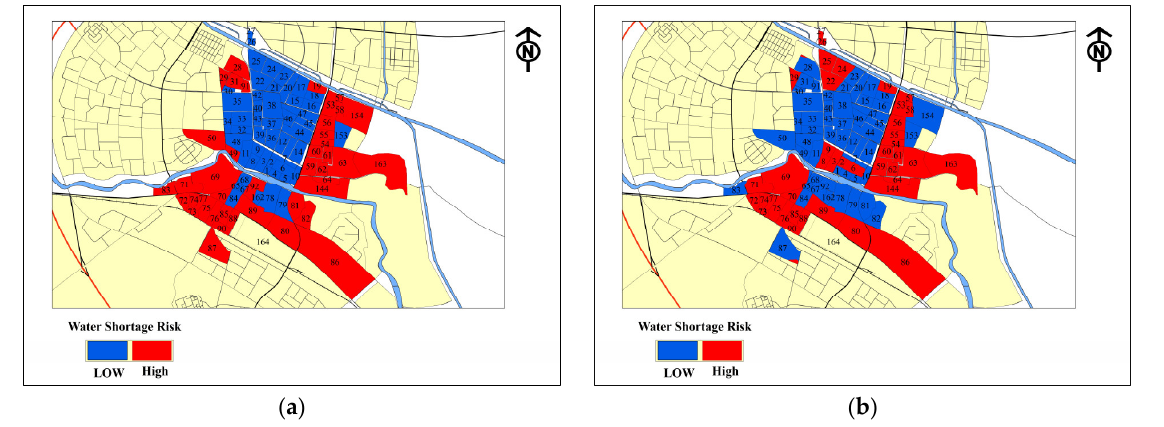
Figure 6. Map ( a ) was created by the direct representative method in GIS, using the prediction results of NB, whereas map ( b ) was produced by the WLC technique of GIS, using the criteria weights gained from NB algorithm.